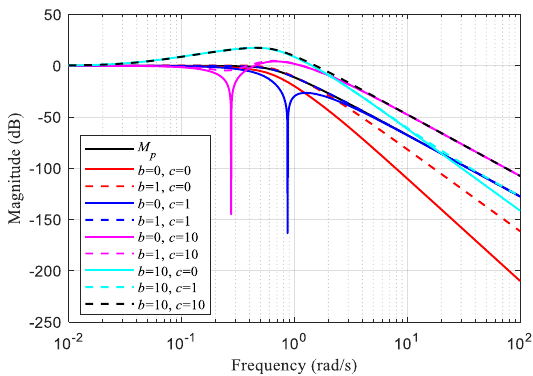
Figure A1. The response of G sp ( s ) in frequency-domain with di ff erent b and c